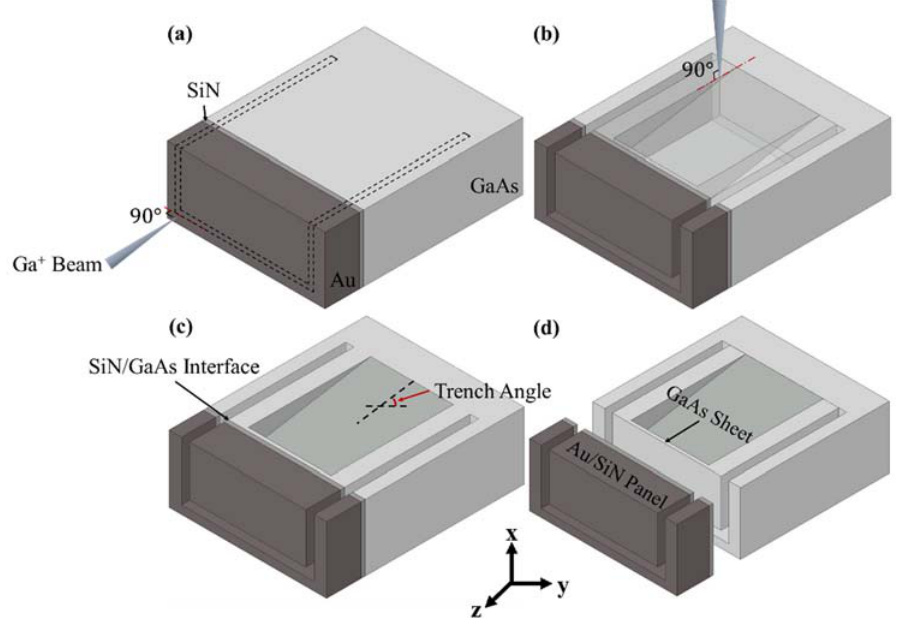
Figure 2. Illustration of the push-out sample milling process: ( a ) milling of the Au/SiN/GaAs rectangular prism, ( b ) milling of the trench, ( c ) final geometry of the push-out specimen, and ( d ) the GaAs thin sheet.